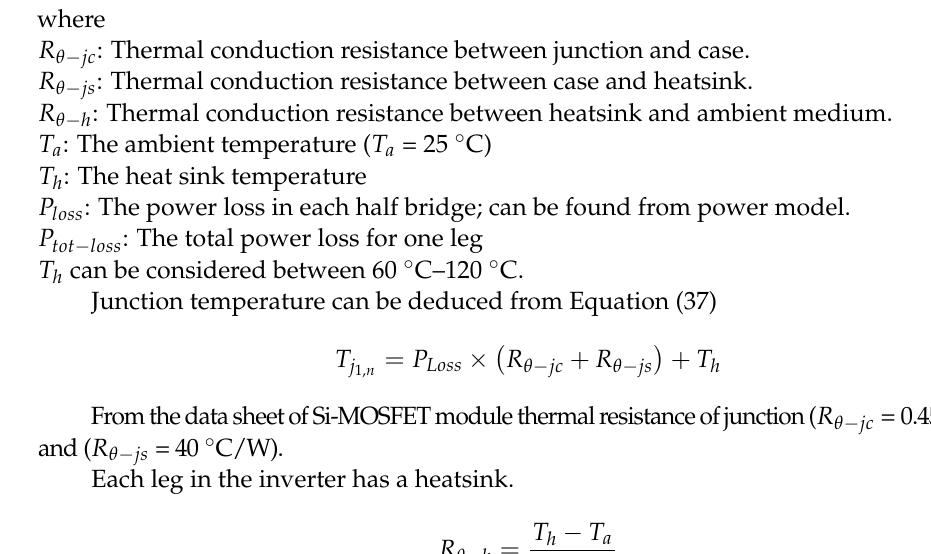
Figure 18. Thermal network circuit for one cell H-bridge.